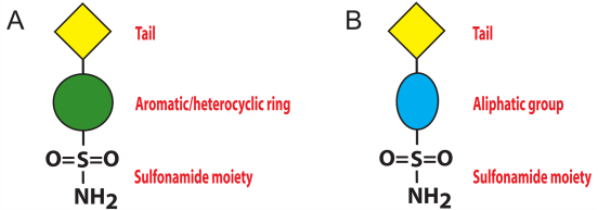
Figure 1. Schematic representation of sulfonamide CA inhibitors: ( A ) aromatic/heterocyclic sulfon- amide; ( B ) aliphatic sulfonamide.